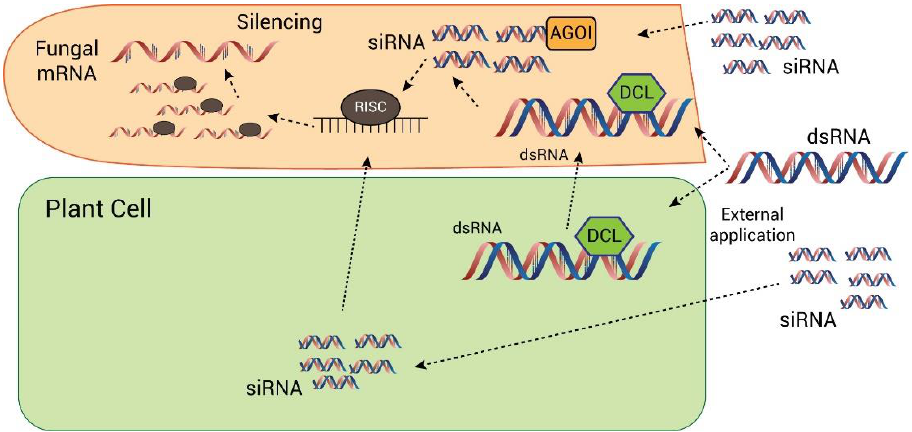
Figure 3. Long double-stranded RNAs (dsRNAs) are transferred to the plants. These are cut into small interfering RNAs (siRNAs) by fungal DCL proteins or plant Dicer-like proteins. The siRNA molecules bind to the complementary sequence of the target mRNA, resulting in its degradation.